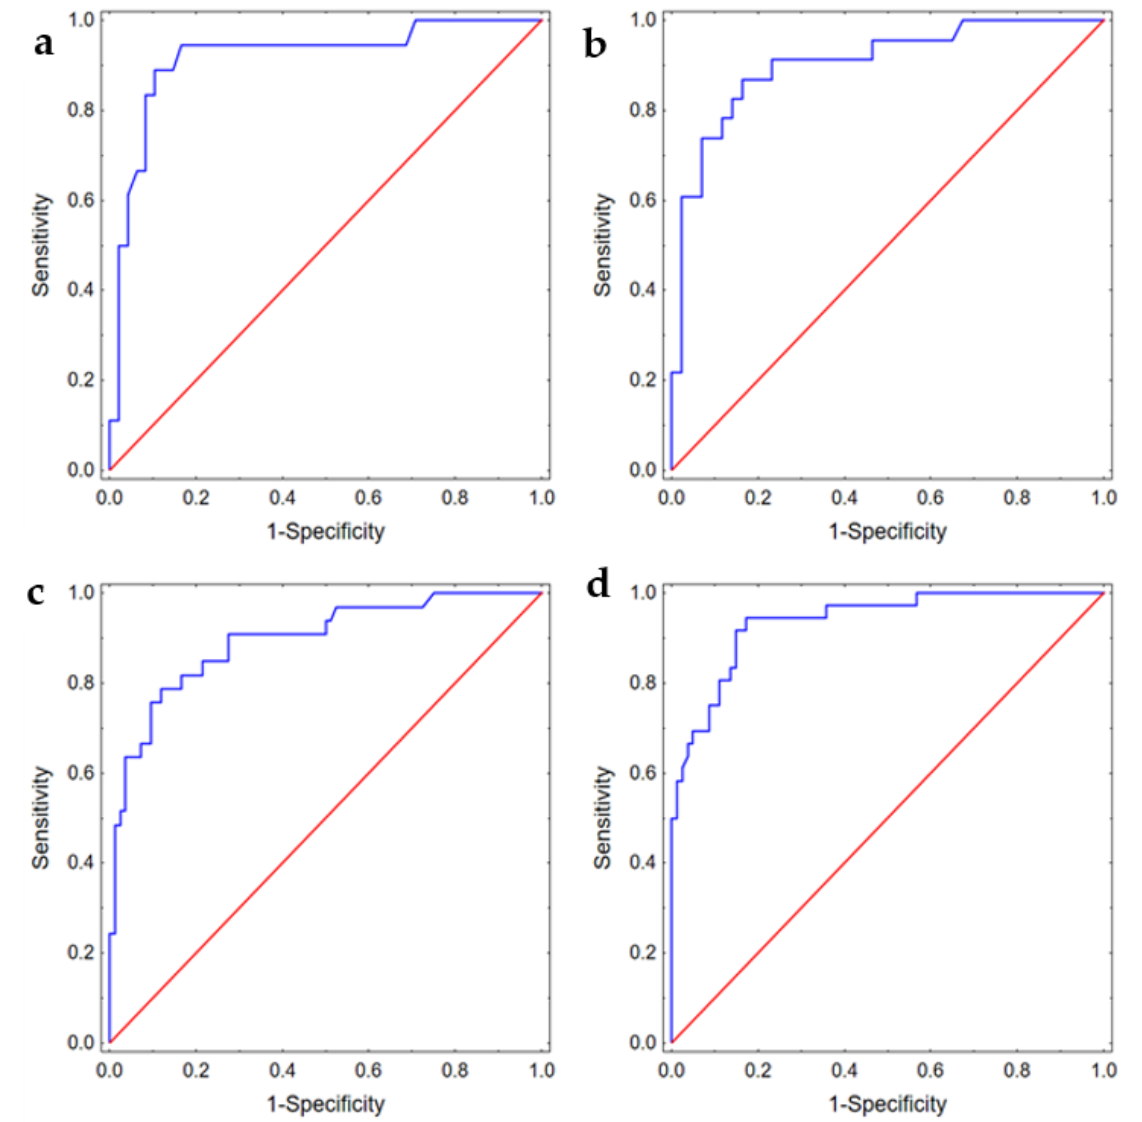
Figure 3. ROC curves presenting discriminating abilities of the models predicting ( a ) recanalization after 6 months in patients with aSAH, AUC 0.92 (95%CI: 0.83–1.00); ( b ) recanalization after 12 months in patients with aSAH, AUC 0.90 (95%CI: 0.83–0.98); ( c ) recanalization after 6 months in patients with unruptured aneurysm, AUC 0.90 (95%CI: 0.83–0.96); ( d ) recanalization after 12 months in patients with unruptured aneurysm, AUC 0.94 (95%CI: 0.89–0.98). Table 4. Multivariable analysis results.